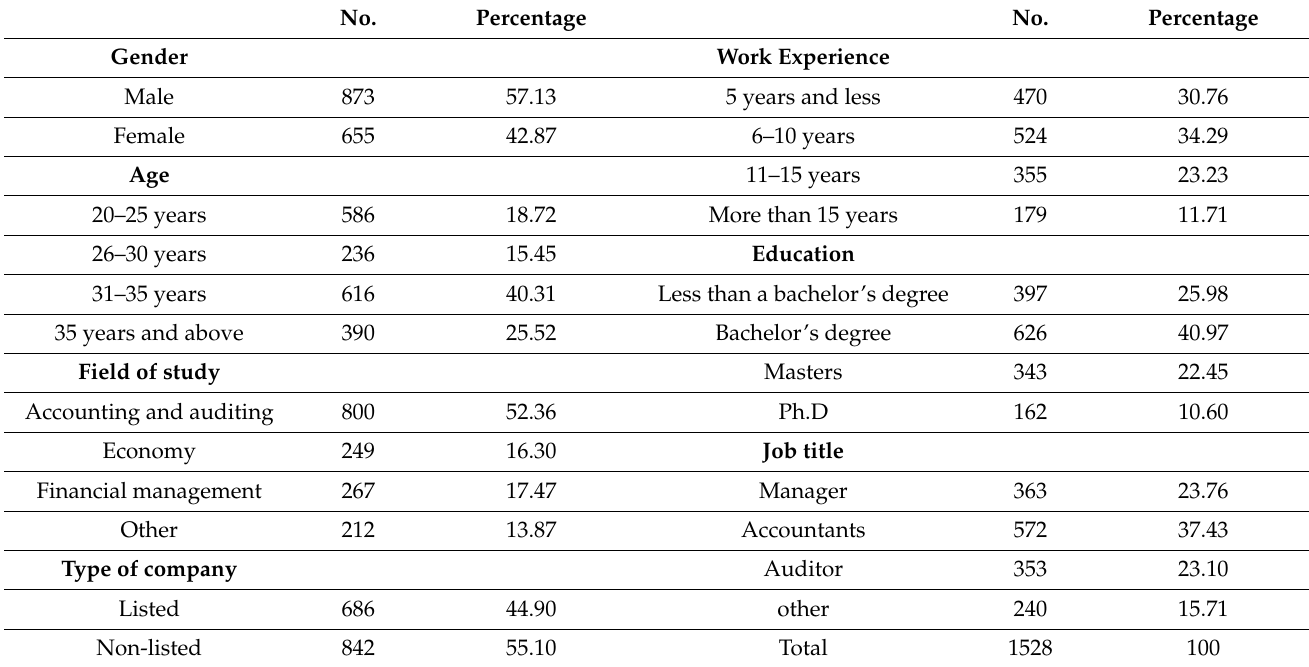
Table 1. The descriptive statistics of the respondents.